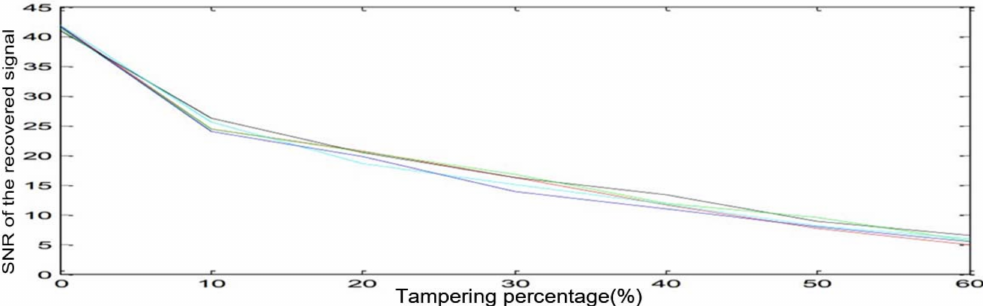
Figure 3. The SNR values of all the recovered speech signal.